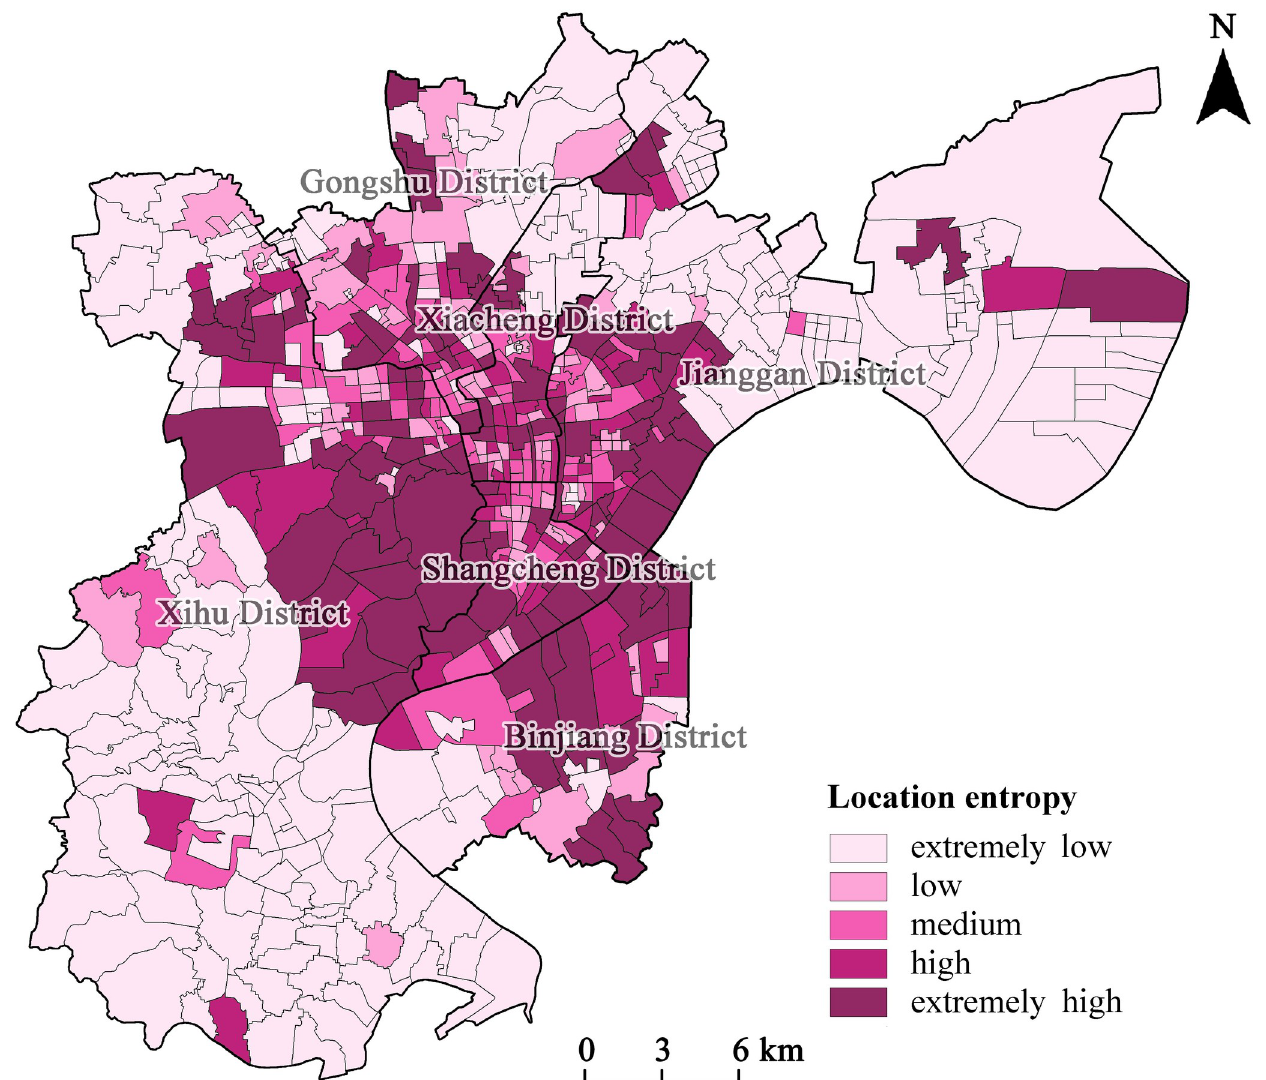
Fig 6. Spatial distribution pattern of per capita public sports facilities resources based on location entropy